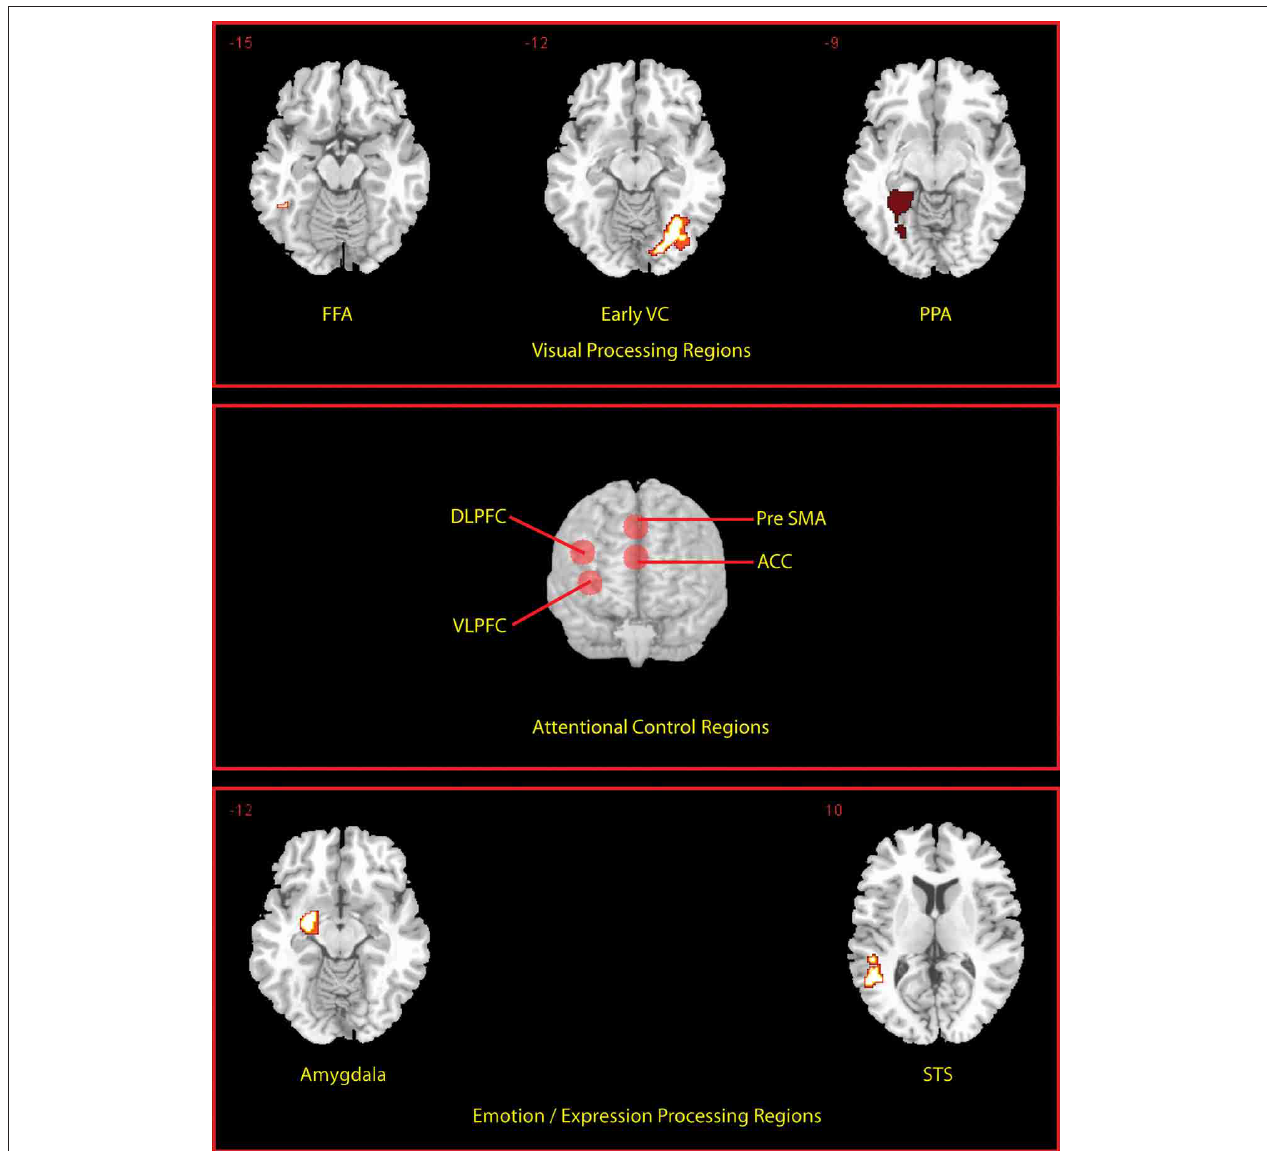
FIGURE 2 | Locations of a priori defined ROIs. Transverse slices for the peak voxel of each of the fROI’s are shown. Prefrontal ROIs are rendered on to the anterior surface of a whole